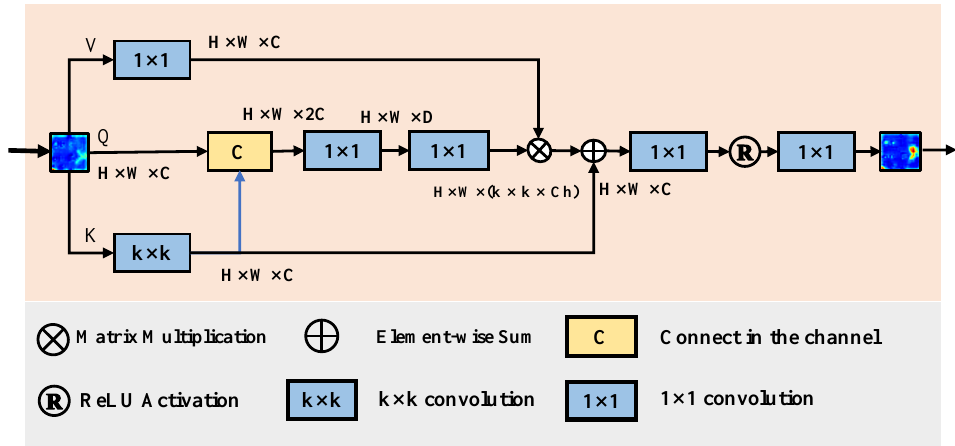
Figure 3. Description of Contextual Feature Generation